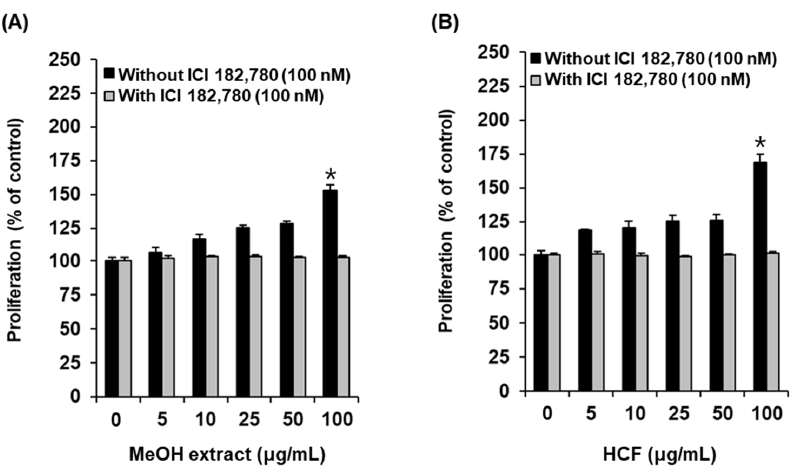
Figure 2. Comparison of estrogenic activities of ( A ) MeOH extract and ( B ) hexane- and CH 2 Cl 2 - soluble fraction (HCF) in the absence or presence of ICI 182,780, as determined by cell proliferation measured by E-screen assay in MCF-7 cells. * Significant difference between untreated cells and cells treated with sample in the absence of ICI 182,780 ( n = 3 independent experiments, p < 0.05, Kruskal–Wallis nonparametric test). Data are the mean ± SEM.